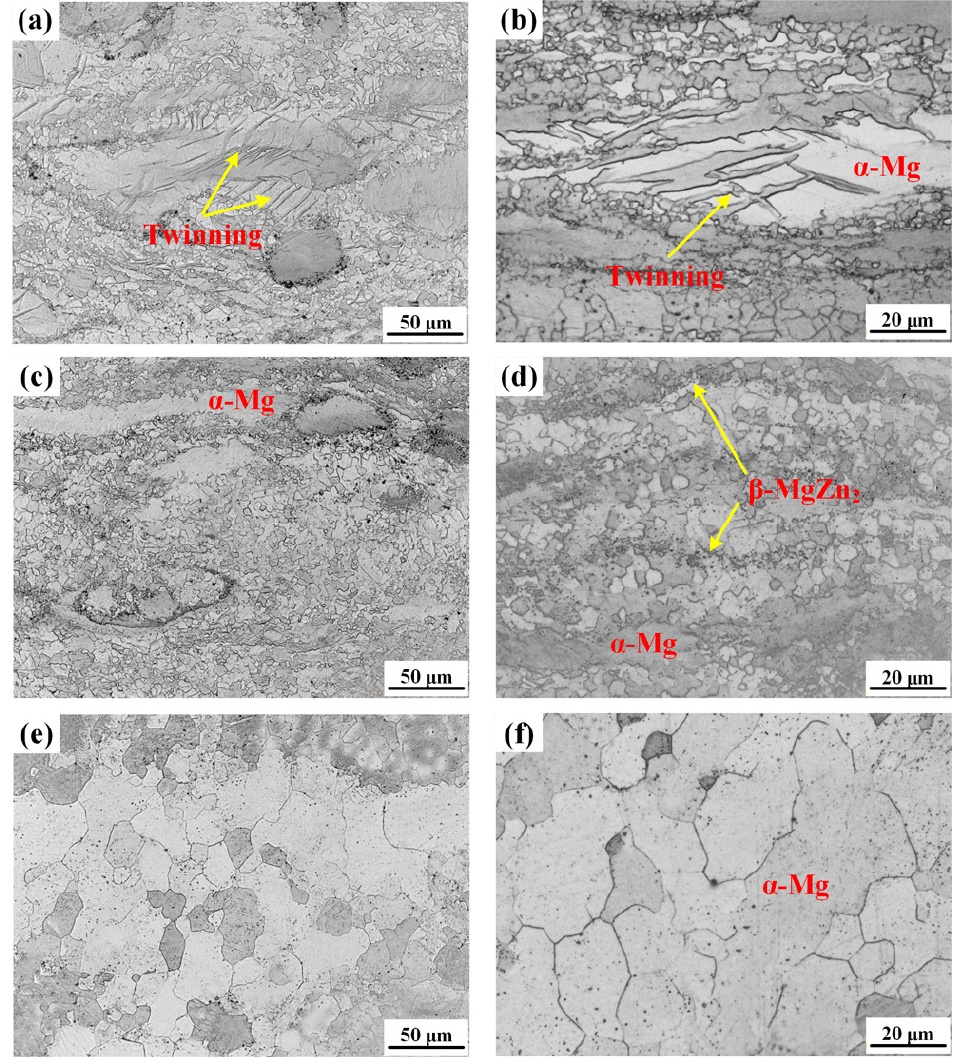
Figure 7. Metallographic images of the ZK60EF alloy forged at the temperature of ( a , b ) 250 °C, ( c , d ) 300 °C, and ( e , f ) 450 °C. ( c , d ) 300 ◦ C, and ( e , f ) 450 ◦